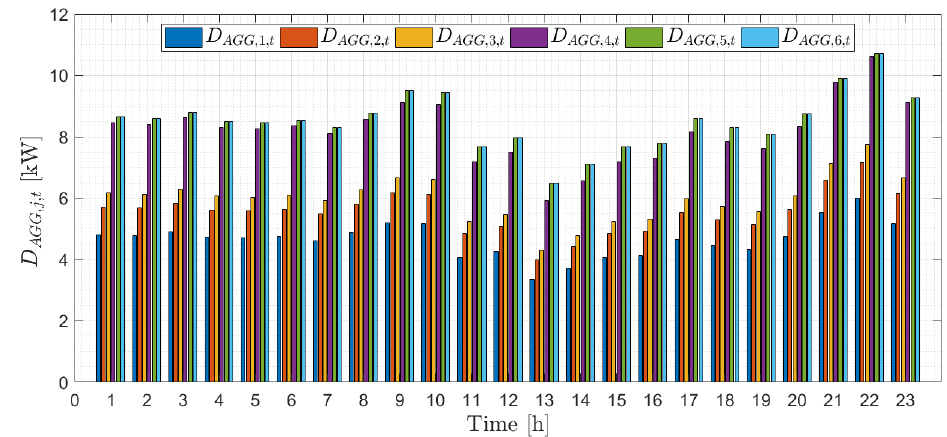
Figure 9. Optimal power reduction resulted from upper-level calculation.